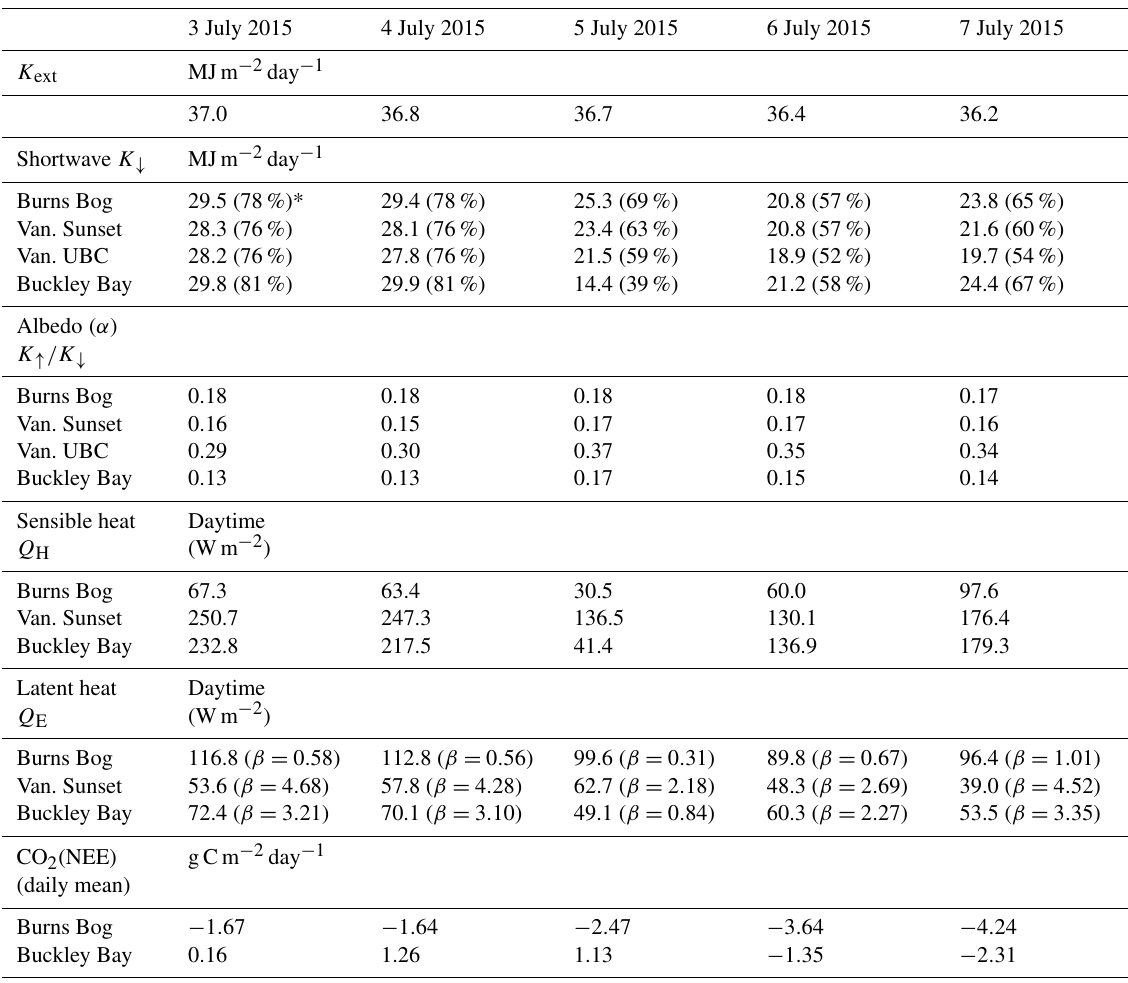
Table 2. Daily averages of radiative and turbulent fluxes, Bowen ratio, and carbon dioxide fluxes on 3–7 July for each of the four